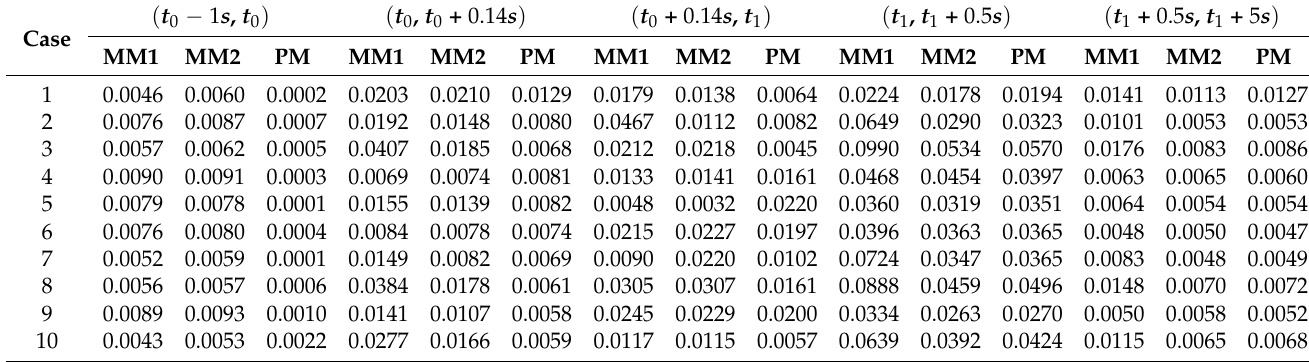
Table 3. Reactive power response error of three equivalent